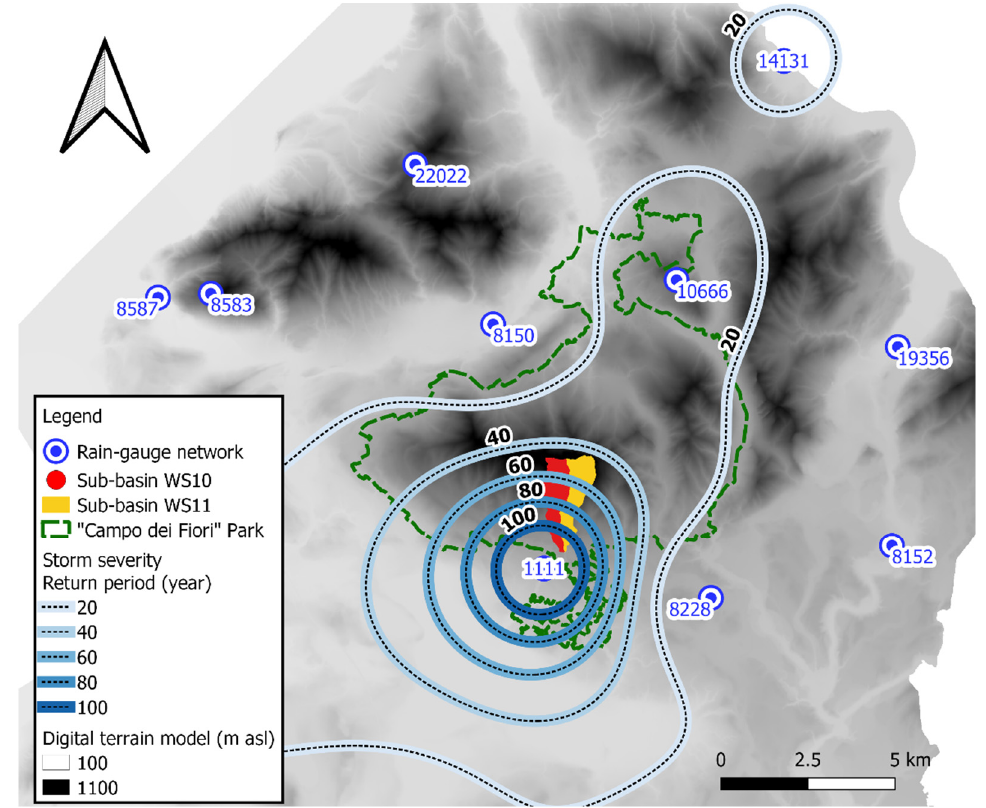
Figure 3. Spatial distribution of storm severity: the coloured contour lines and the labels written in black describe the return period of storm (year), whereas the labels in blue describe the rain- gauge stations.